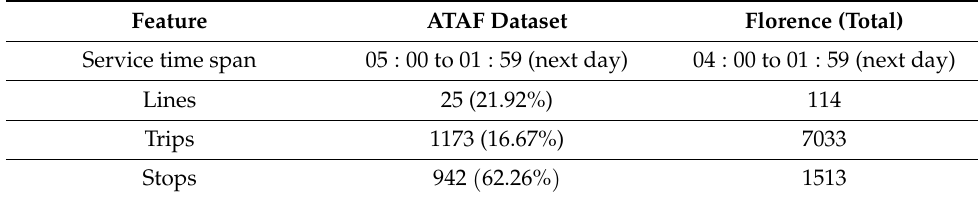
Table 3. ATAF dataset description.